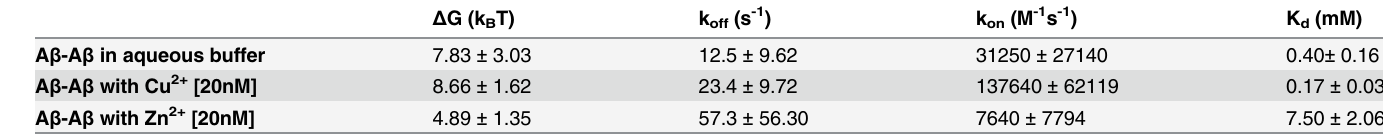
Table 1. Kinetic and thermodynamic parameters for A β -A β unbinding in aqueous buffer, Cu 2+ [20nM] and Zn 2+ [20nM]